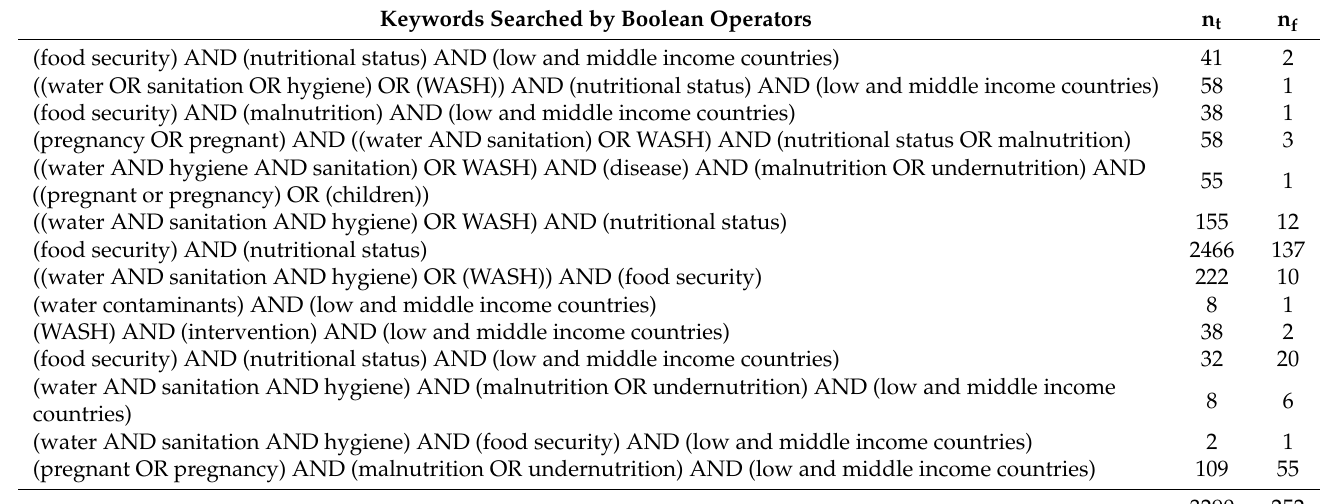
Table 1. Search strategy and the number of articles (n t ) found and selected (n f